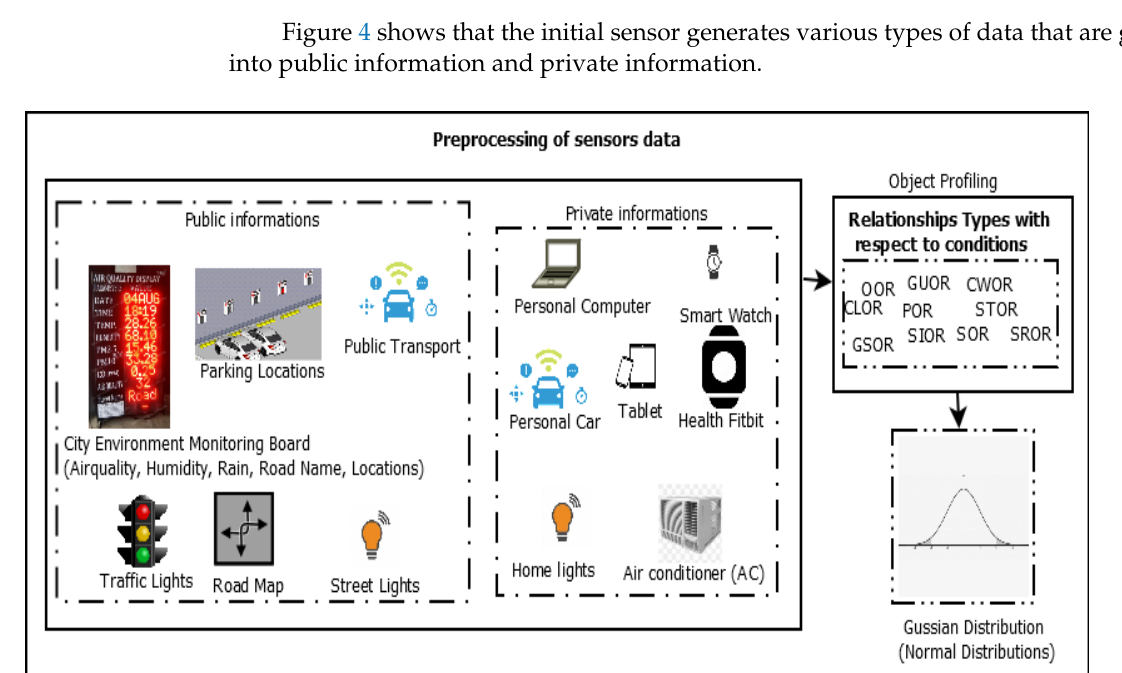
Figure 4. Sensor data preprocessing from random to Gaussian